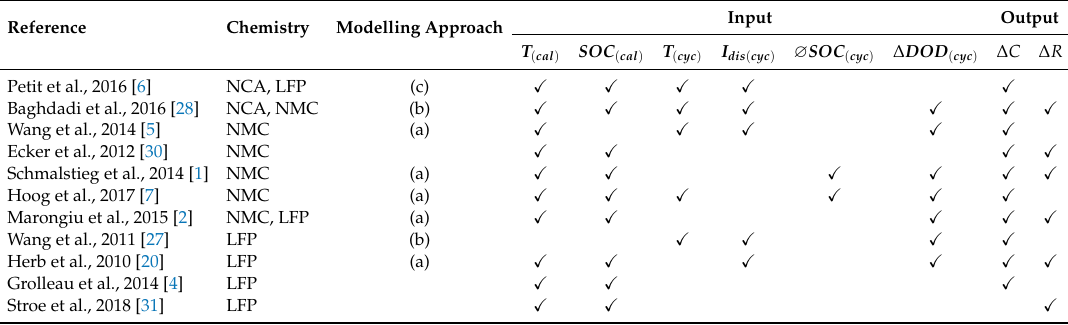
Table 2. Overview of semi-empirical aging models: Indication of the cell chemistry, the modeling approach according to Figure 2 (if both calendar and cyclic aging are considered), the considered stress factors as model input parameters (differentiation between stress factors for calendar or cyclic aging) and aging effects as model output. This overview consolidates the controversy on relevant stress factors for cyclic aging, as shown in Table